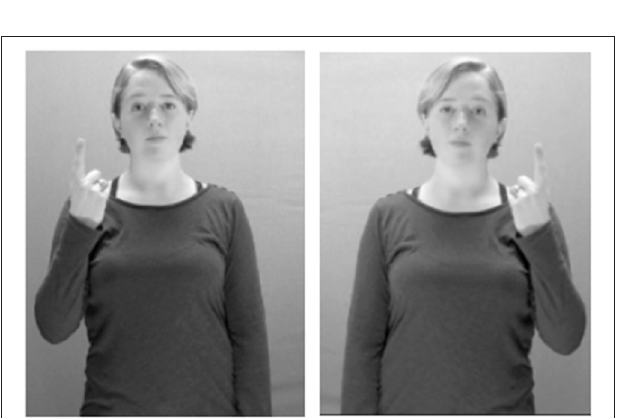
FIGURE 6 | An example of how a gesture stimulus from Study 1 (left) was flipped horizontally to appear as if produced by a left-handed gesture model in Study 2 (right) . Still images of gesture stimuli are reproduced here and in Table 2 with written permission of the